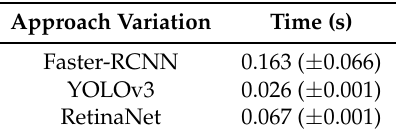
Table 3. Computational cost of the proposed approach variants. The time is the average in seconds to execute the deep learning methods on an